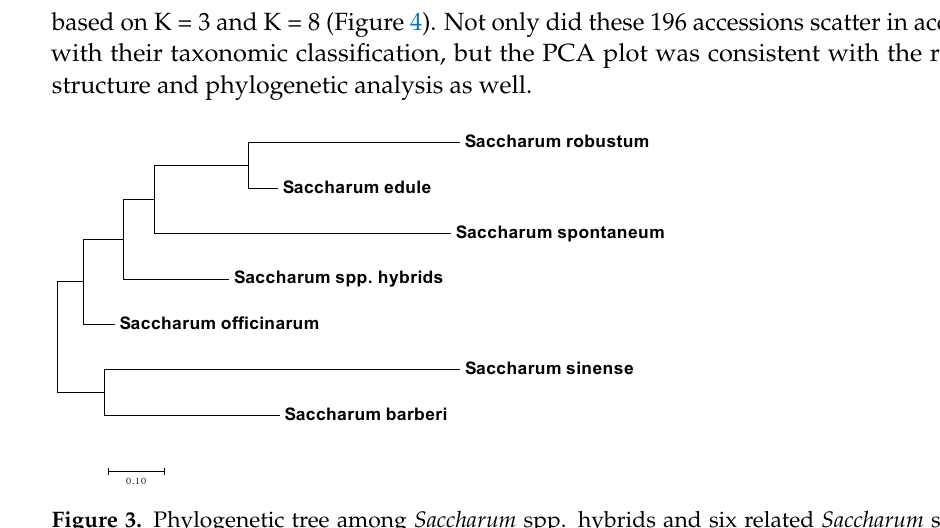
Figure 3. Phylogenetic tree among Saccharum spp. hybrids and six related Saccharum species: S. spontaneum , S. robustum , S. officinarum , S. sinense , S. barberi , and S. edule based on the genetic distance matrix using the neighbor-joining method by Power Marker v. 3.25 and visualized using the software MEGA 7.